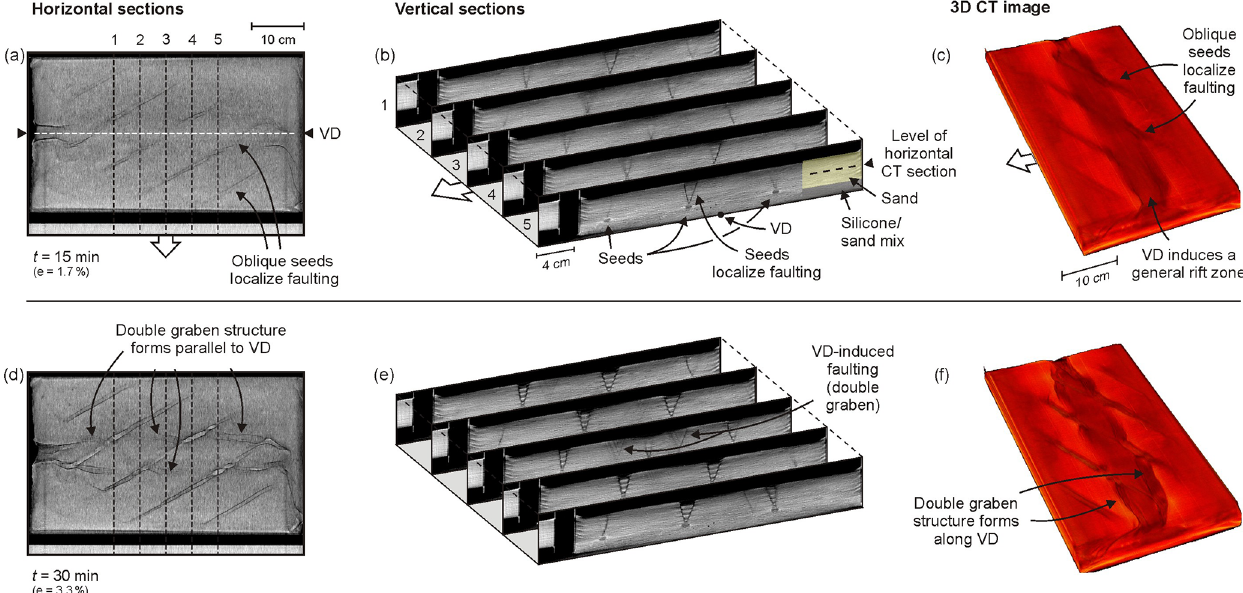
Figure 3. CT analysis of Model D (model axis-parallel VD, − 30 ◦ oblique seeds, CT-scanned rerun of Model C). (a, d) Horizontal sections through the brittle layer. (b, e) Serial cross sections. (c, f) 3D CT images. Note that the colours in these images represent CT-scanning intensities and are not to be interpreted as a measure of model surface altitude.